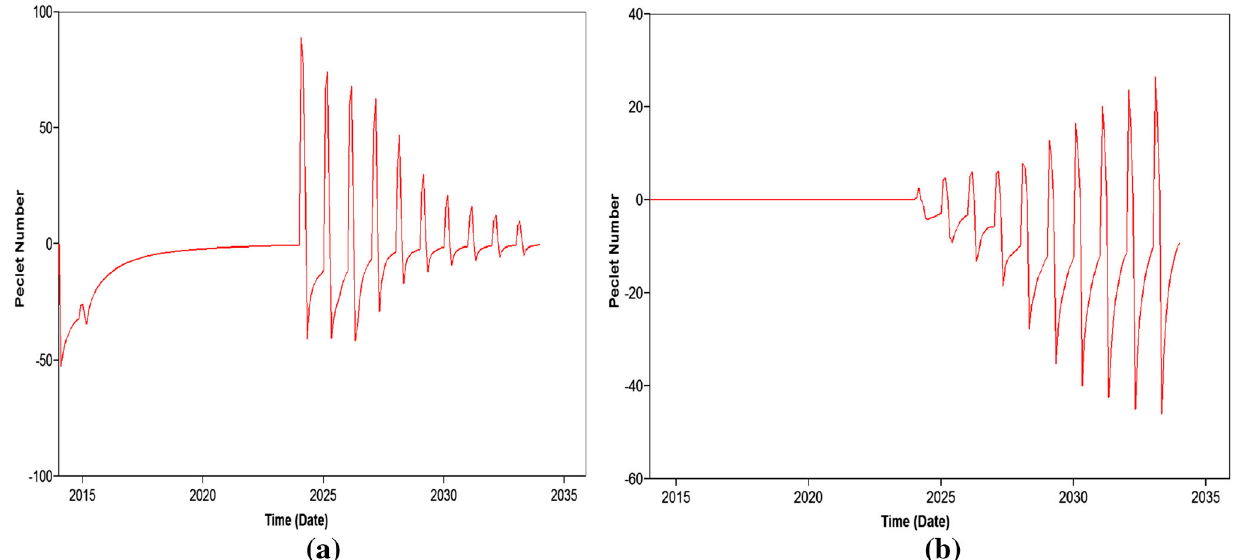
Fig. 9 Pe´clet number change with time (At 10 ft from the hydraulic fracture). a Oil phase. b Gas phase Table 5 Summary for flow-type regimes for natural depletion and EOR stage